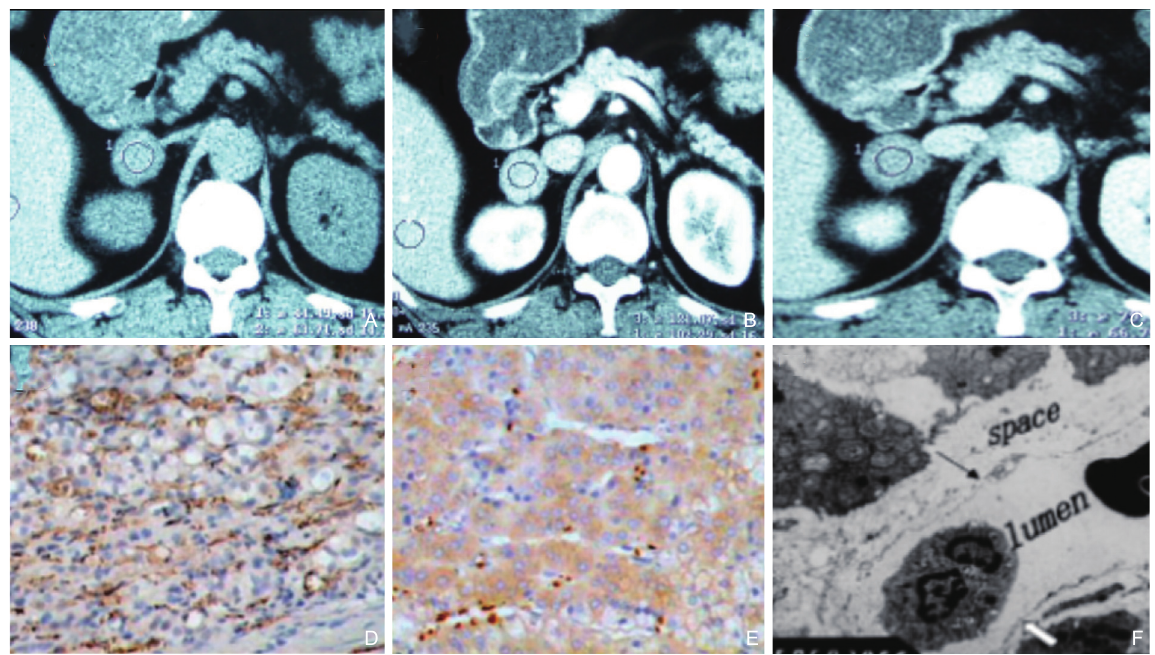
Figure 1 Right lipid-poor adrenal adenoma. (A-C) DCE-CT showed rapid washout with TD curve of Type A, Washr of 34 %, Washa of 53 % at 7-min delay time point; (D) MVD immunohistochemistry (× 200), numerous blood vessels with round lumens, showing higher MVD; (E) VEGF immunohistochemistry (× 200), high positive rate of cells with brown or yellow-brown granules in the cytoplasm, showing high VEGF expression; (F) Microvascular ultrastructure. Transmission electron microscopy (TEM) (× 5000) demonstrated a regular lumen without significant stenosis, a smooth luminal surface, the presence of an excess of pinocytotic vesicles and fenestrations of endothelial cells (thin arrow), a uniform thinning of the basement membrane (empty arrow), a regular and uniform thinning of most of the extravascular space, and the presence of less stroma.